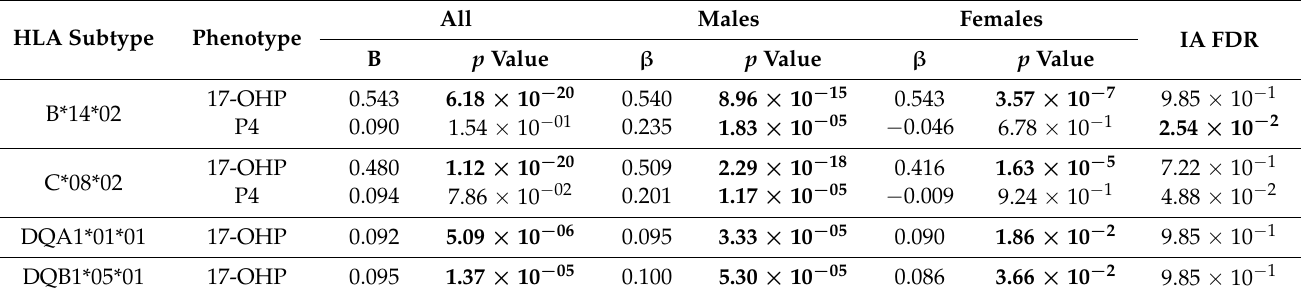
Table 3. Results from meta-analyses of the HLA subtypes on 17-OHP and P4. Significant associations are marked in bold. Allele dose associations were calculated in each study and then combined (fixed-effect meta-model). Further statistics are given in Table